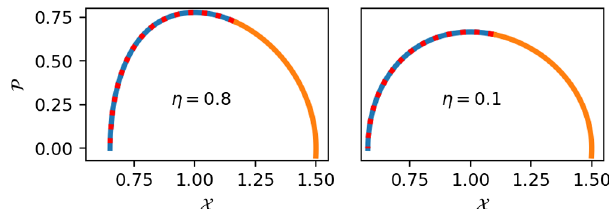
FIG. 10. Envelope data with sampling period slightly larger than the stroboscopic period by 0.1%. The left and right plots are at η ¼ 0 . 8 , X ð 0 Þ ¼ 0 . 651 and η ¼ 0 . 1 , X ð 0 Þ ¼ 0 . 577 respec- tively. Blue is the forward 256 samples, orange is the next forward 256 samples and the red dashed line is the backward 256 samples after the first forward tracking.